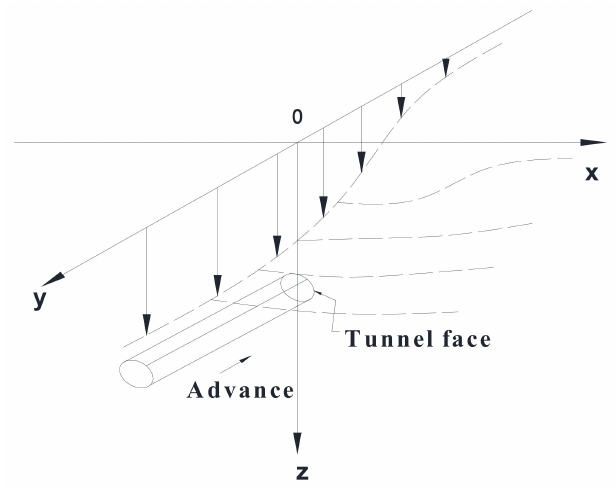
Figure 2. Surface displacement caused by shield